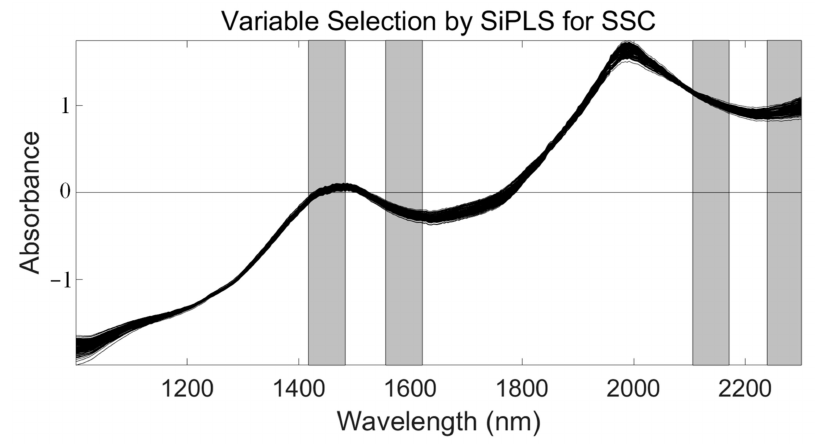
Figure 6. The four synergy subintervals (gray part) selected for SSC by the SiPLS algorithm, based on the SNV preprocessed spectra.